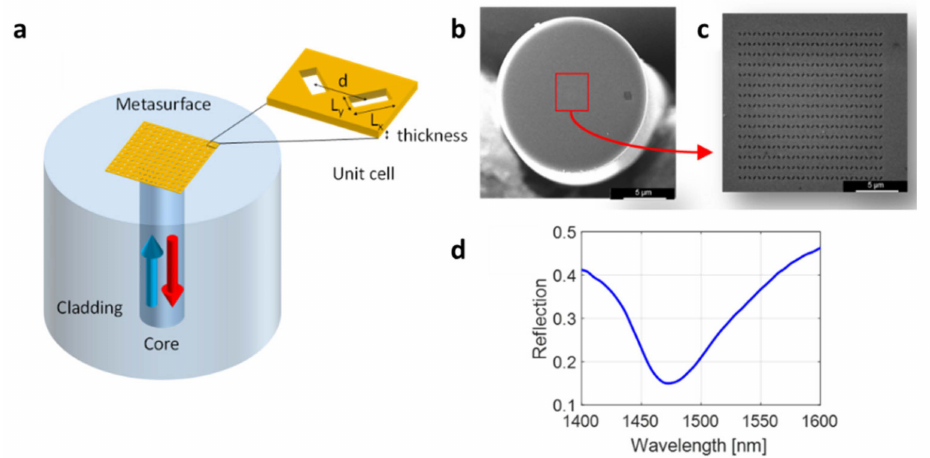
Figure 2. Basic schematic of an OFMT ( a ); SEM image of an OFMT ( b ); zoomed image of the nanopattern of a phase-gradient OFMT ( c ); reflection spectrum of a realized phase-gradient MT probe ( d